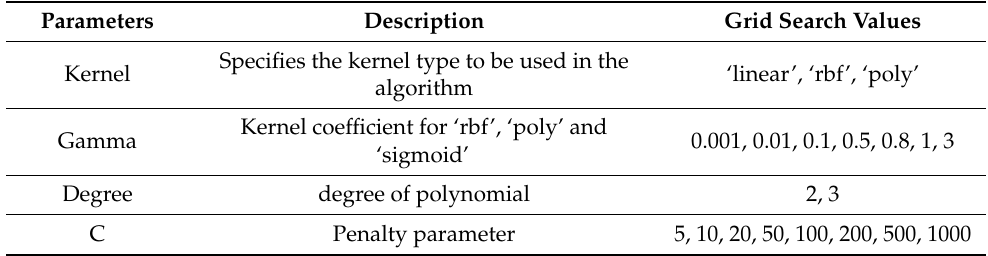
Table 4. GridSearchCV parameters for